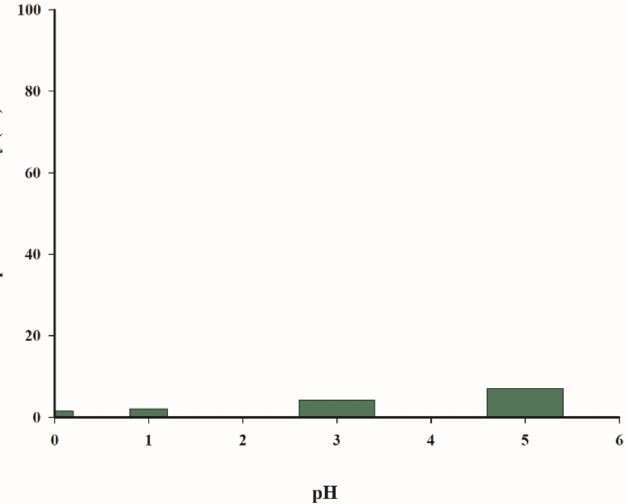
Figure 12. Effect of pH on the adsorption efficiency of arsenic(III) (T = 298.15 K, t = 240 min, c = 100 mg · dm − 3 , mass of adsorbent = 3.33 g · dm − 3